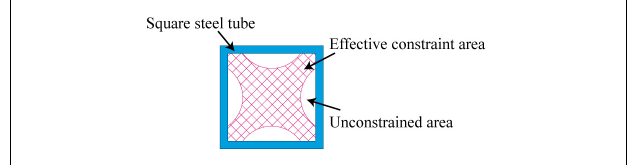
FIGURE 1 | Section constraint diagram of a square steel